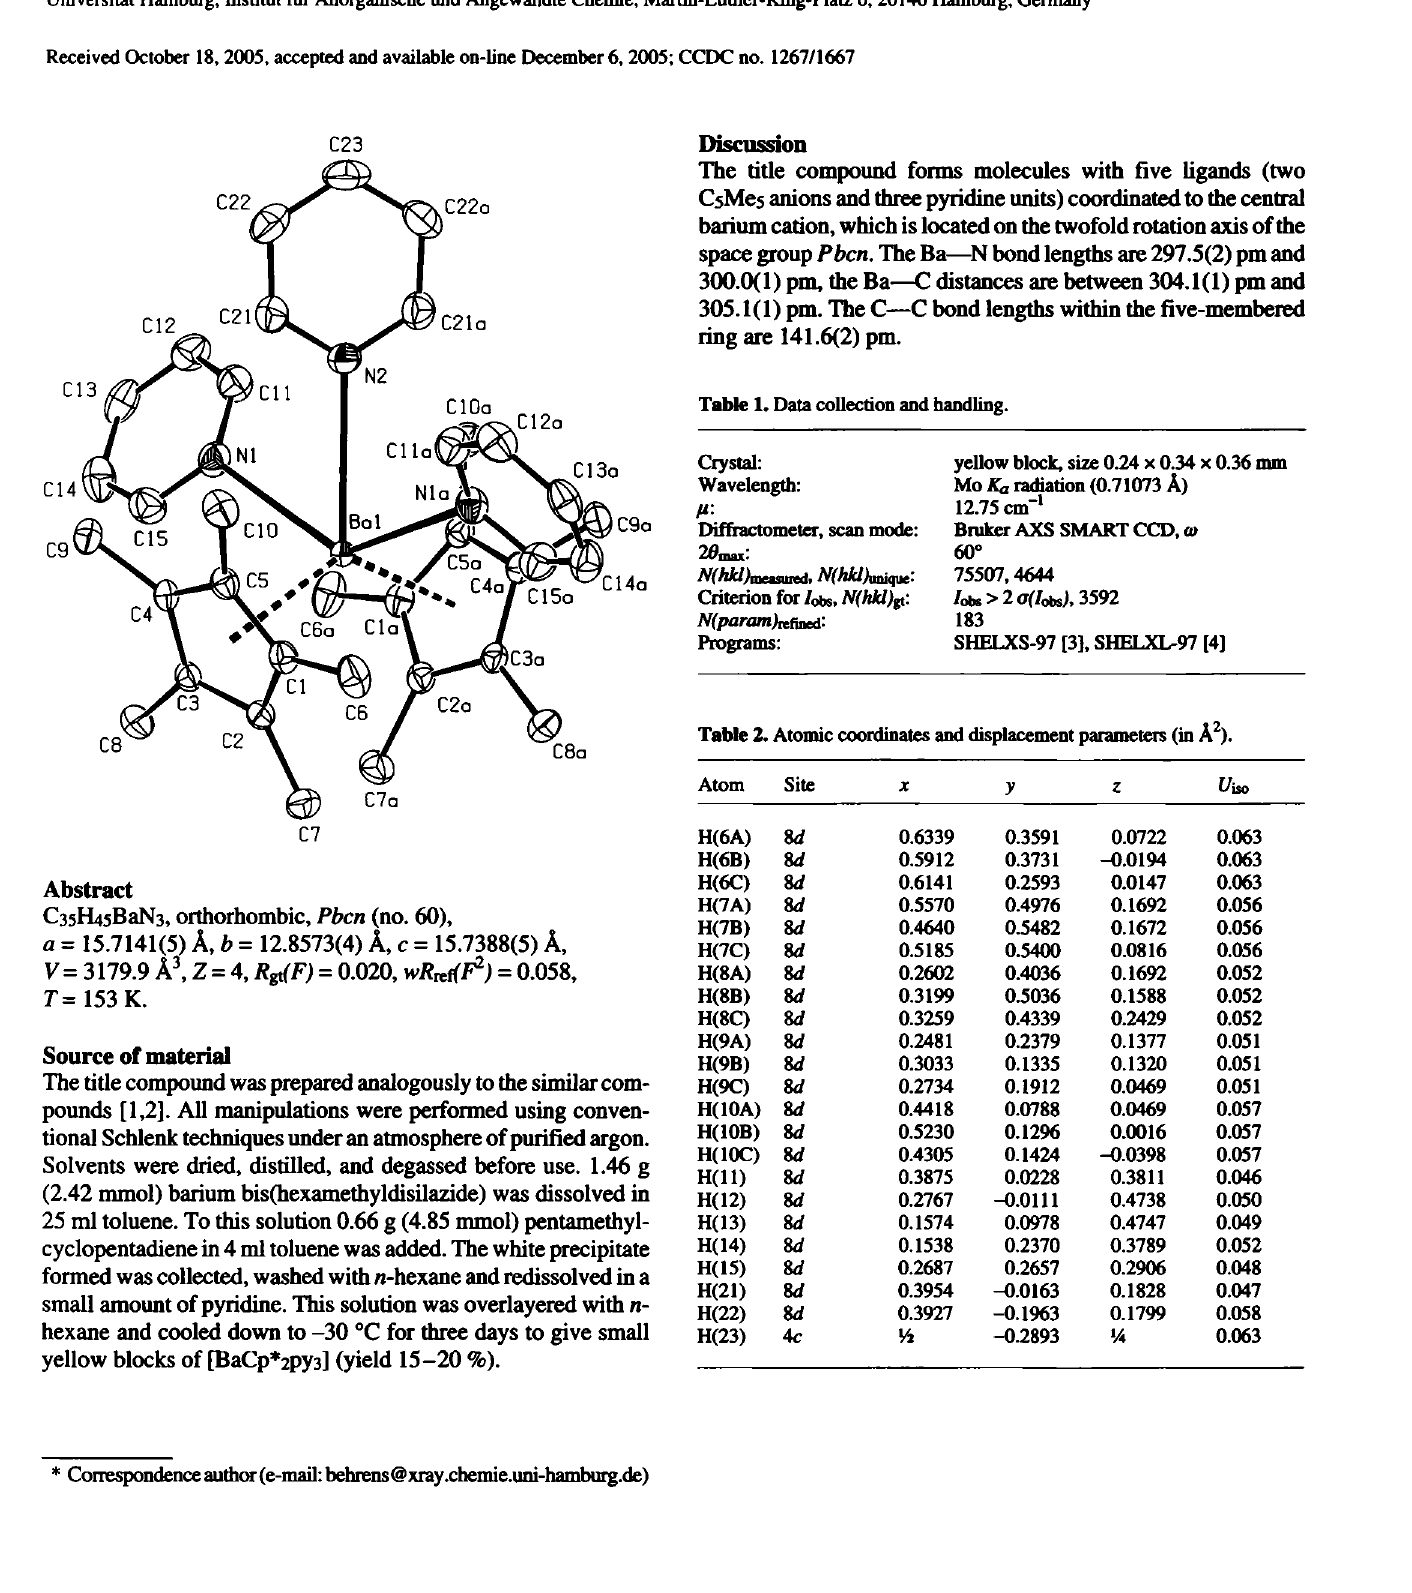
Table 1. Data collection and handling.